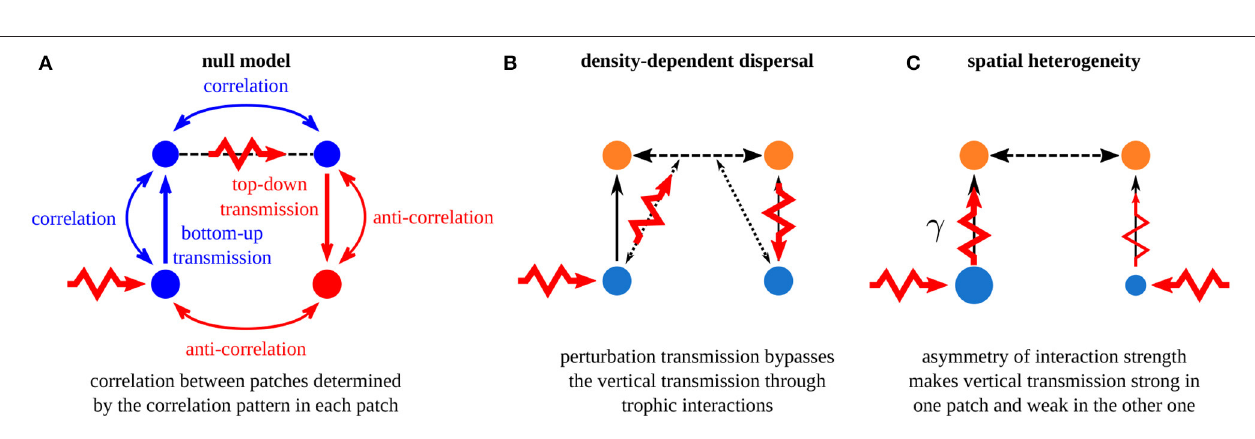
FIGURE 13 | Summary of the mechanisms governing synchrony in metacommunities. (A) Fundamental rules of perturbation transmission in a homogeneous metacommunity with passive dispersal. (B) Density-dependent dispersal alters the horizontal transmission of perturbations. (C) Spatial asymmetry alters the biomass densities and the vertical transmission of perturbations in each